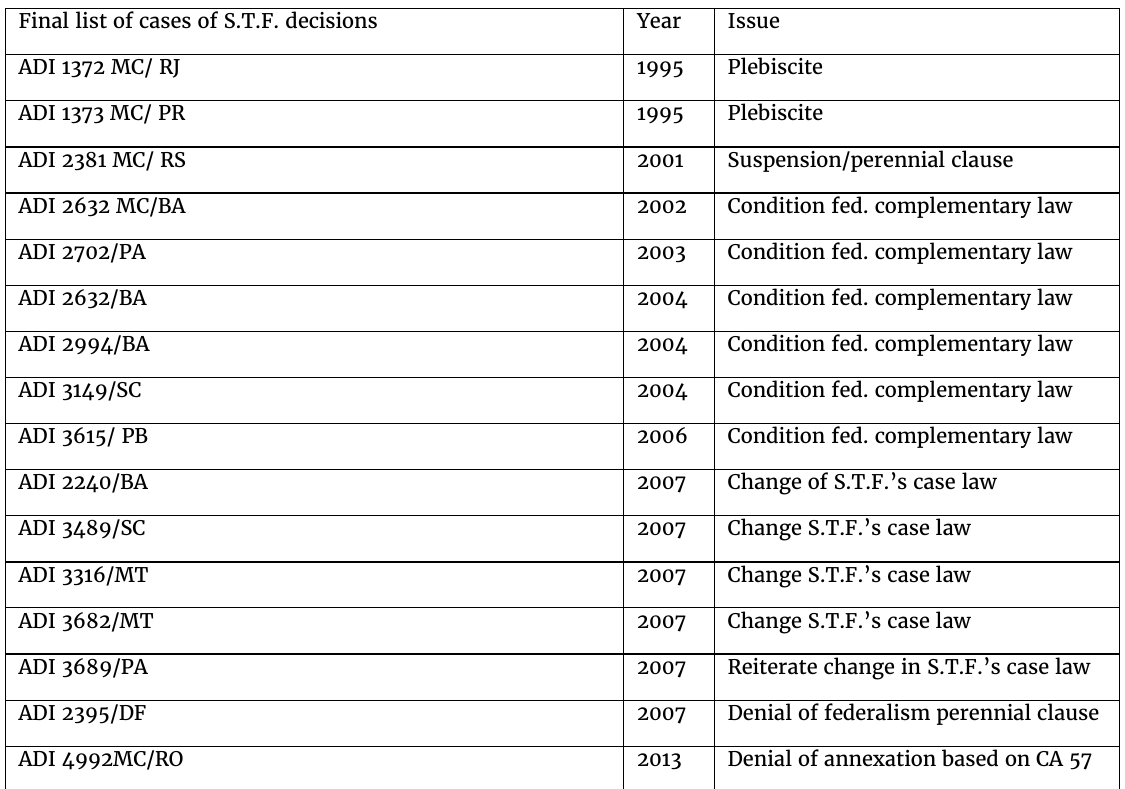
Table 2: Final decisions of the S.T.F. Final list of cases of S.T.F.